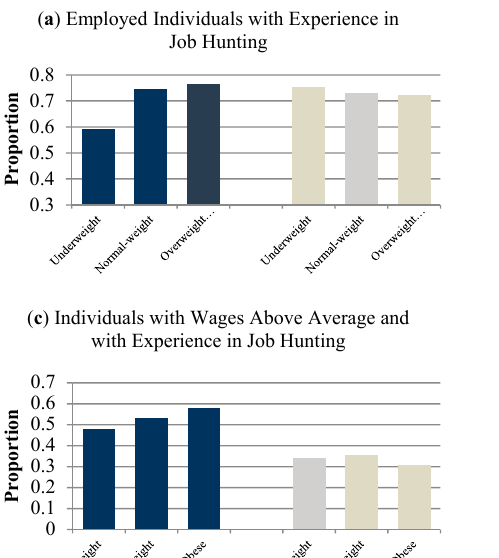
Key Independent Variable